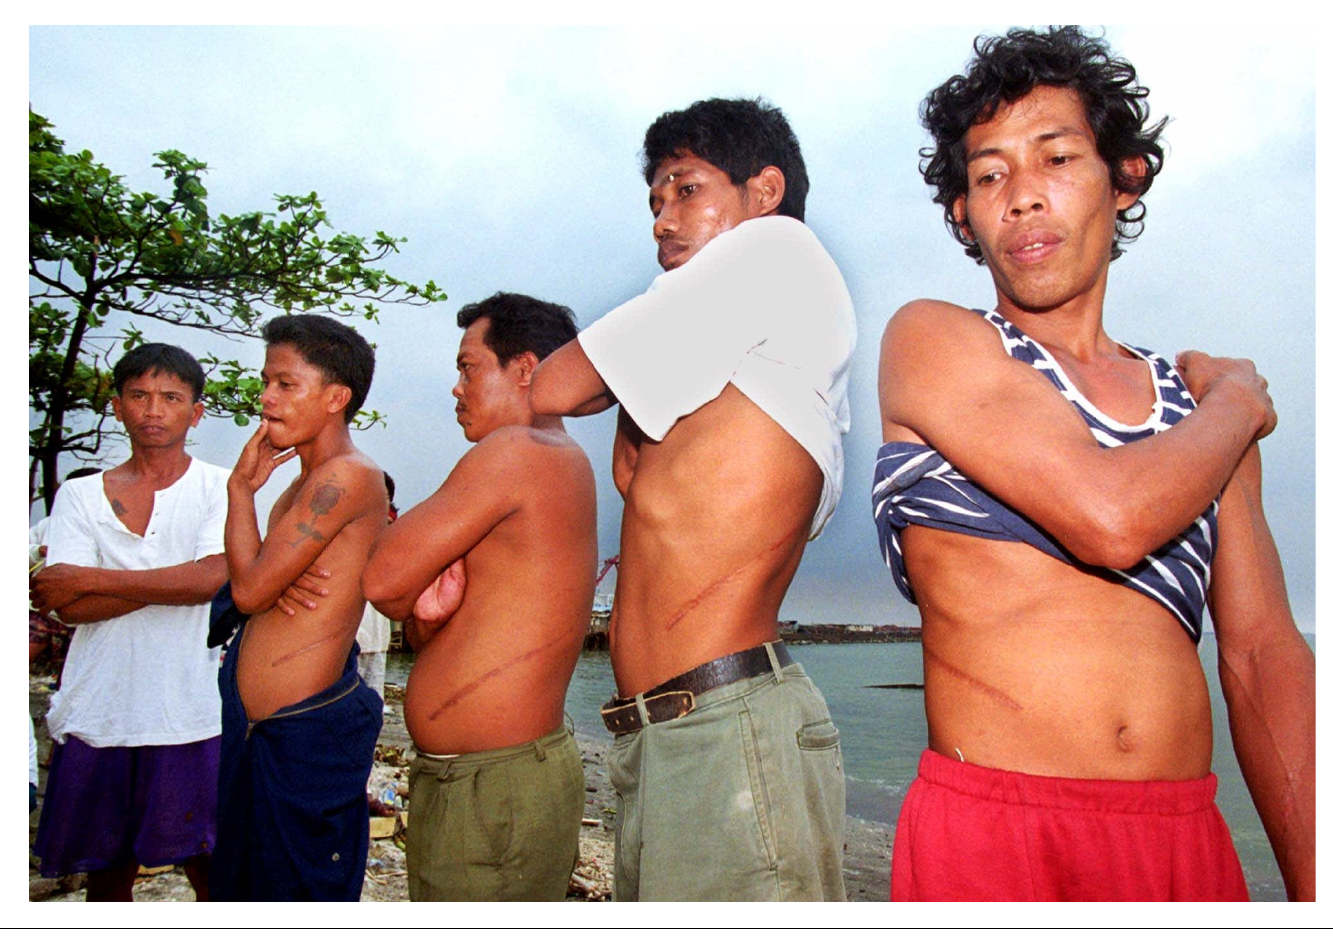
Figure 2. Filipino men displaying their scars from kidney surgery. 10